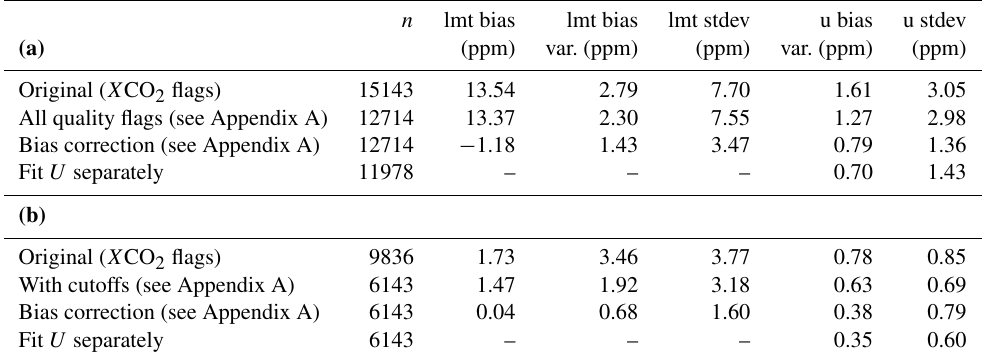
Table A2. (a) Effects of bias corrections and quality flags on land comparisons (ESRL aircraft land observations). (b) Effects of bias corrections and quality flags on ocean comparisons (HIPPO and ESLR ocean dataset stations and campaigns: tgc, rta, aoa, 2S, 2N, 3S, 3N, 4S, 4N, 5S,